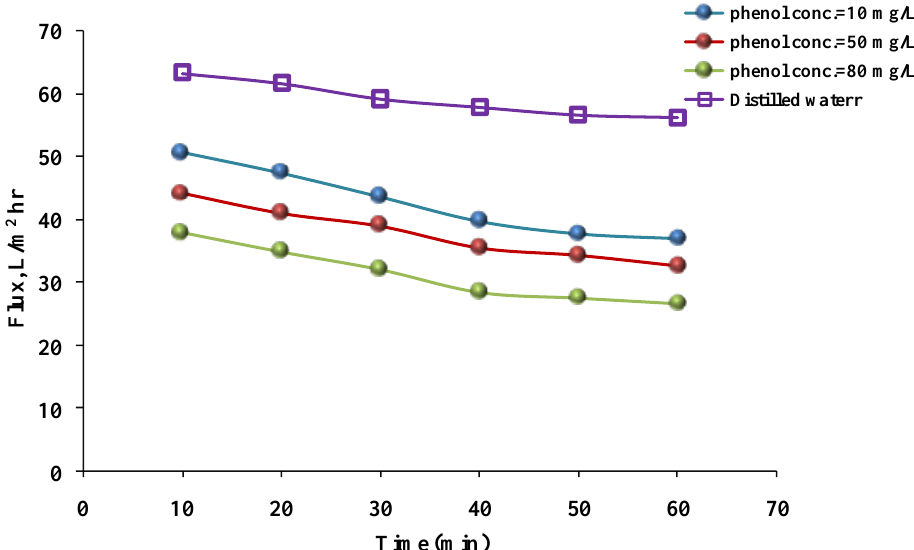
Figure 7. Phenol solution and distilled water’s fluxes with time for a hydrophilic membrane at different concentrations (pressure = 1 bar, temperature = 30 ◦ C).